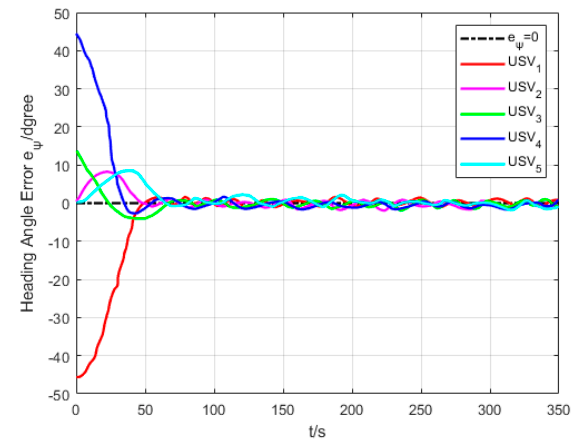
Figure 20. Heading angle error (Algorithm 3).